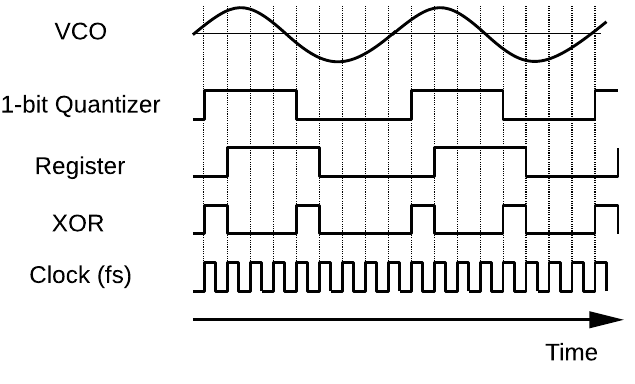
Figure 3. Time chart of the